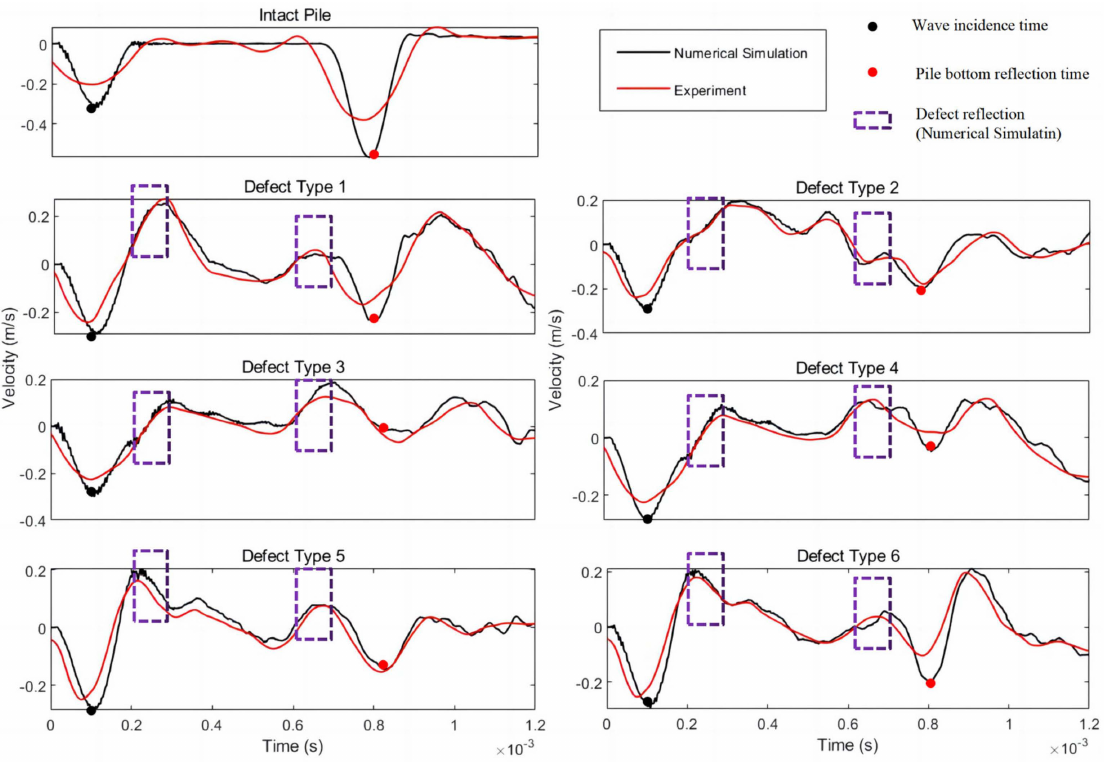
Figure 7. Comparison of numerical simulation and experimental